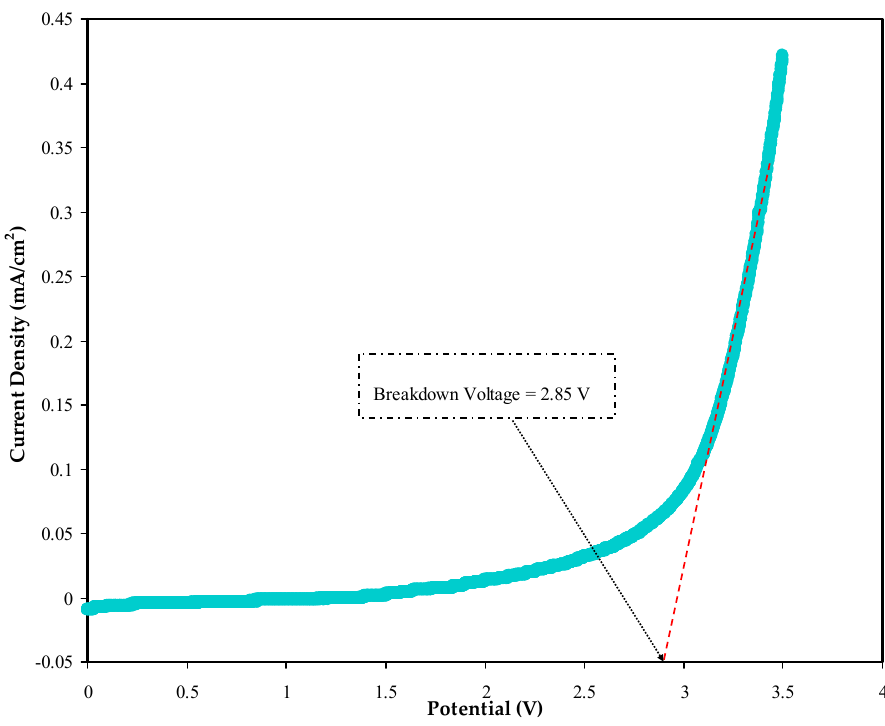
Figure 11. Determination of decomposition voltage for the BGNN5 system with the highest conduc- tivity through the LSV plot.